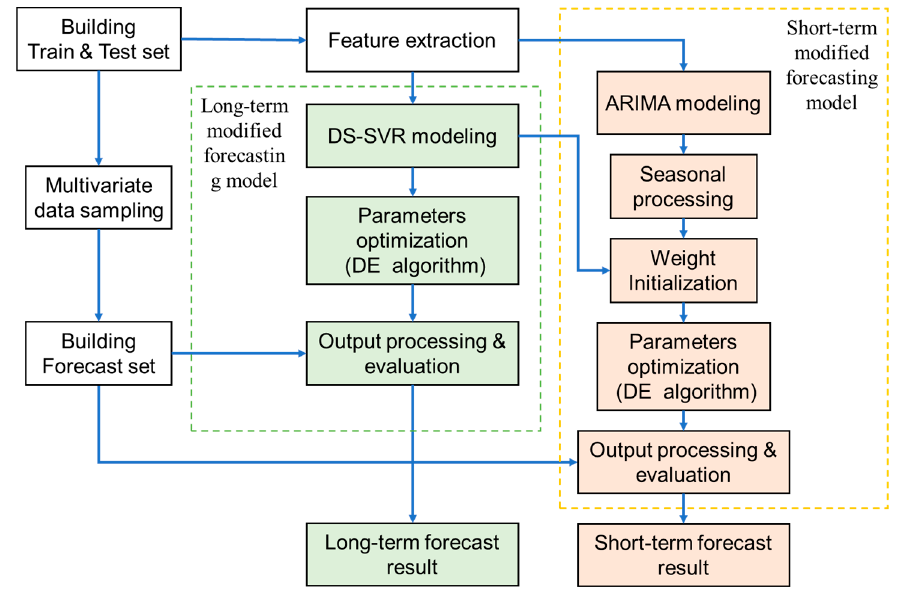
Figure 1. Long-term and short-term market decision-making model based on ARIMA and SVR compound parameter adjustment algorithm.